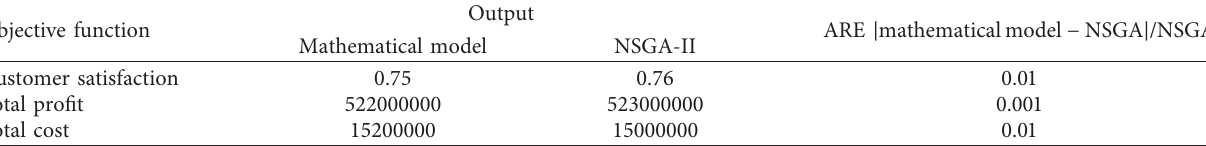
Table 6: Validation.